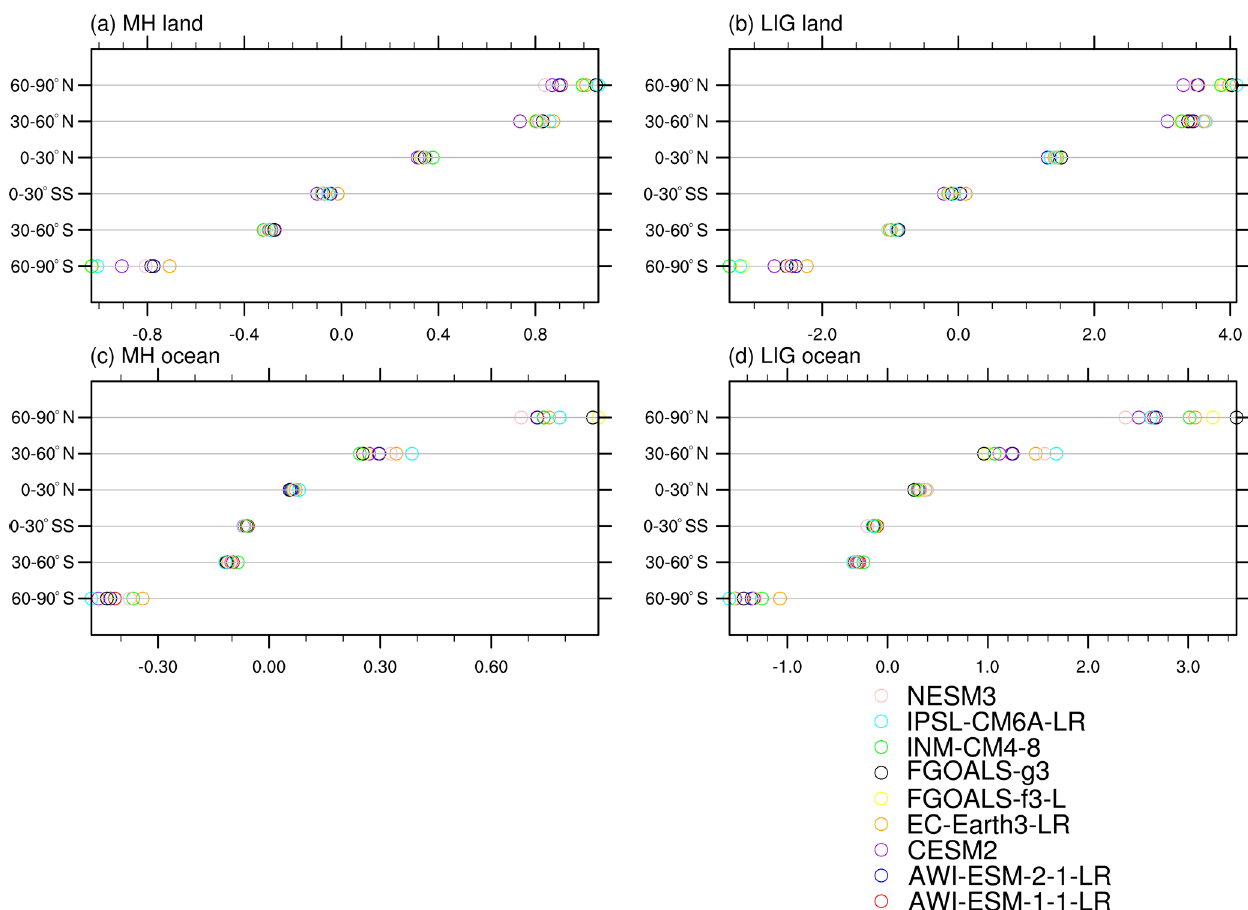
Figure 5. (a, b) Deviation of MH-PI SON surface air temperature between angular and classical means for (a) continents and (b) oceans at different latitude bands, simulated by individual models. (c, d) As in (a, b) , but for LIG-PI surface air temperature. Units: